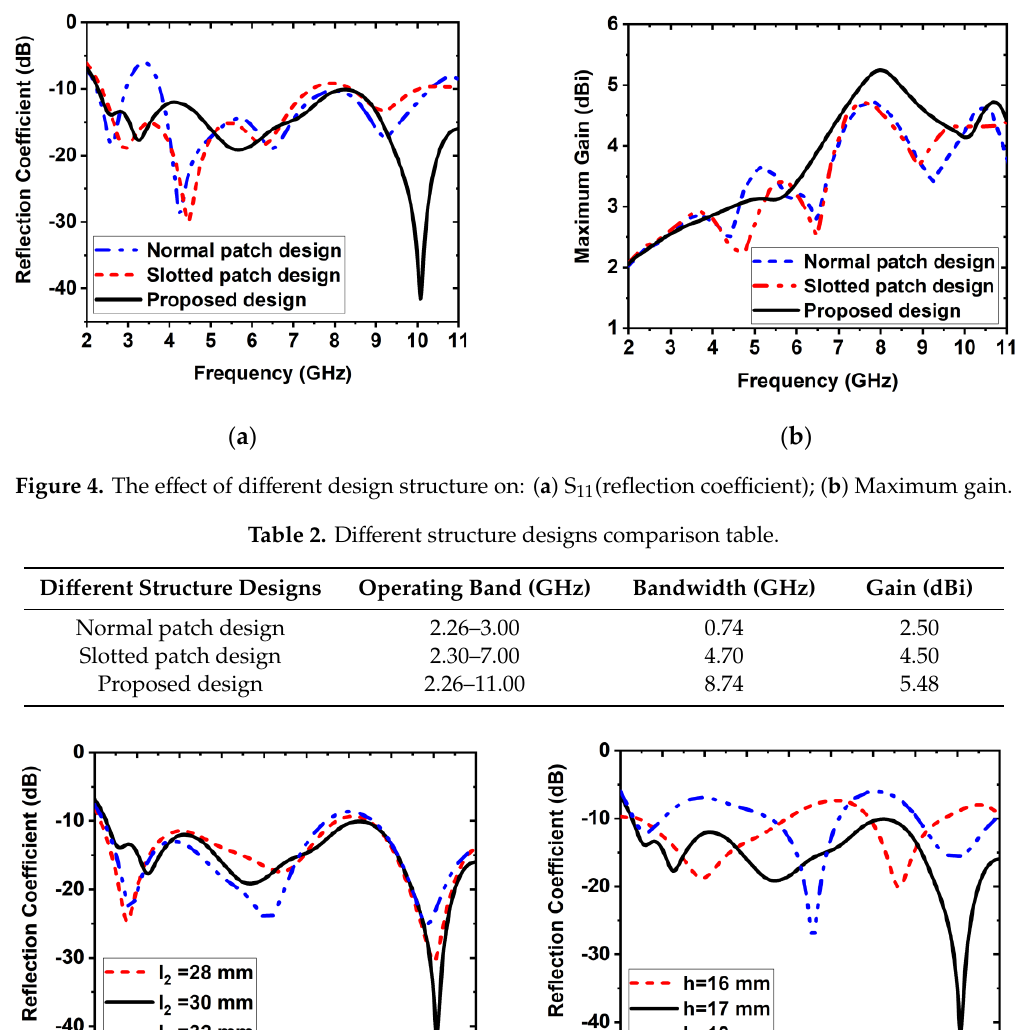
Figure 3. Different modifications of the proposed prototype: ( a ) Normal patch design; ( b ) Slotted patch design; ( c ) Proposed design.